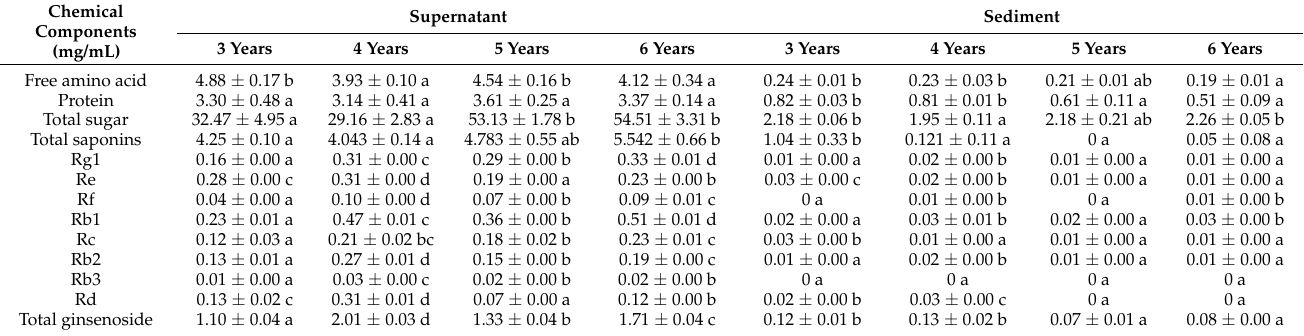
Table 1. Analysis of the chemical composition of the extract and sediment of ginseng of different